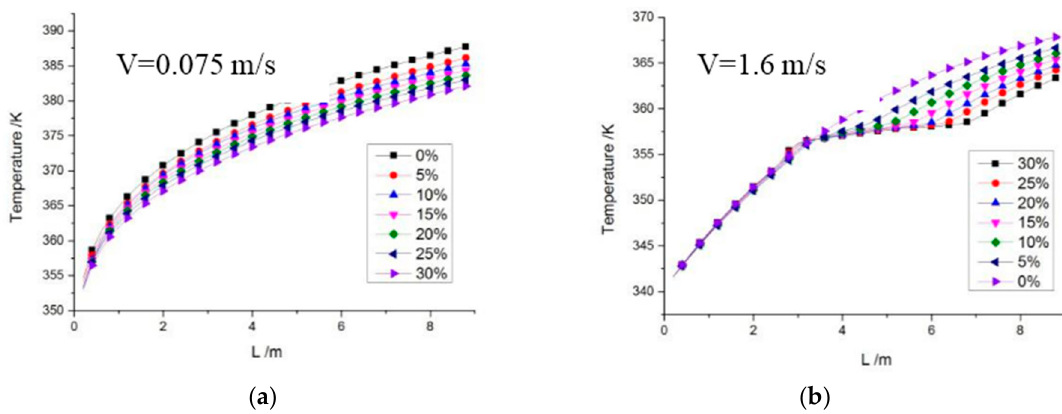
Figure 5. Average temperature distribution along the tube. ( a ) Laminar flow; ( b ) Turbulent flow.